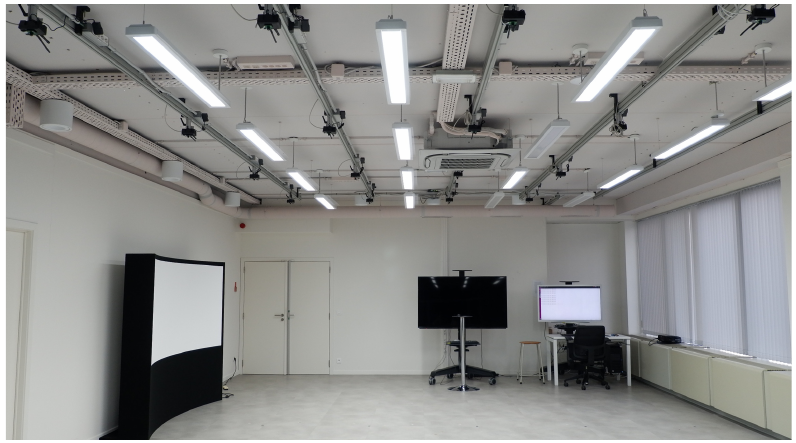
Figure 1. The proposed distributed VSN system, with 16 raspberry-pi cameras on the ceiling and a central service on the